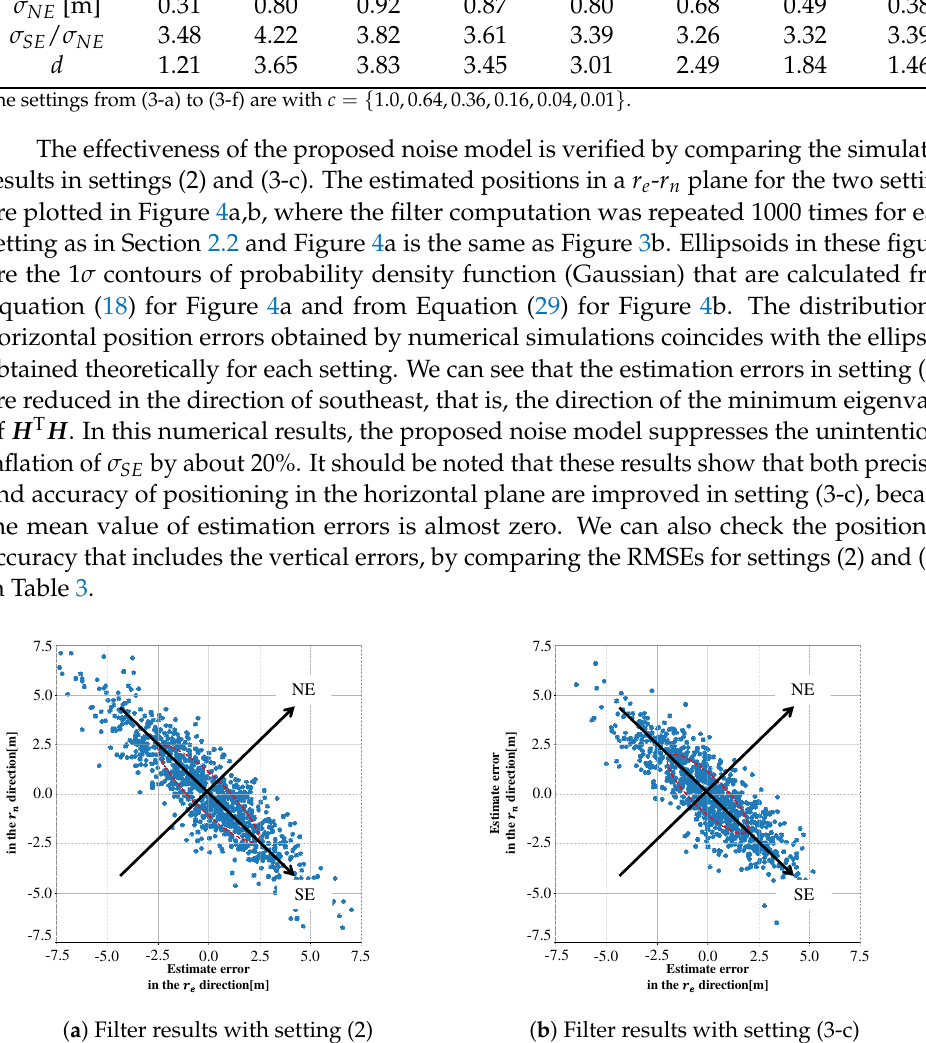
Figure 4. Estimated positions obtained for settings (2) and